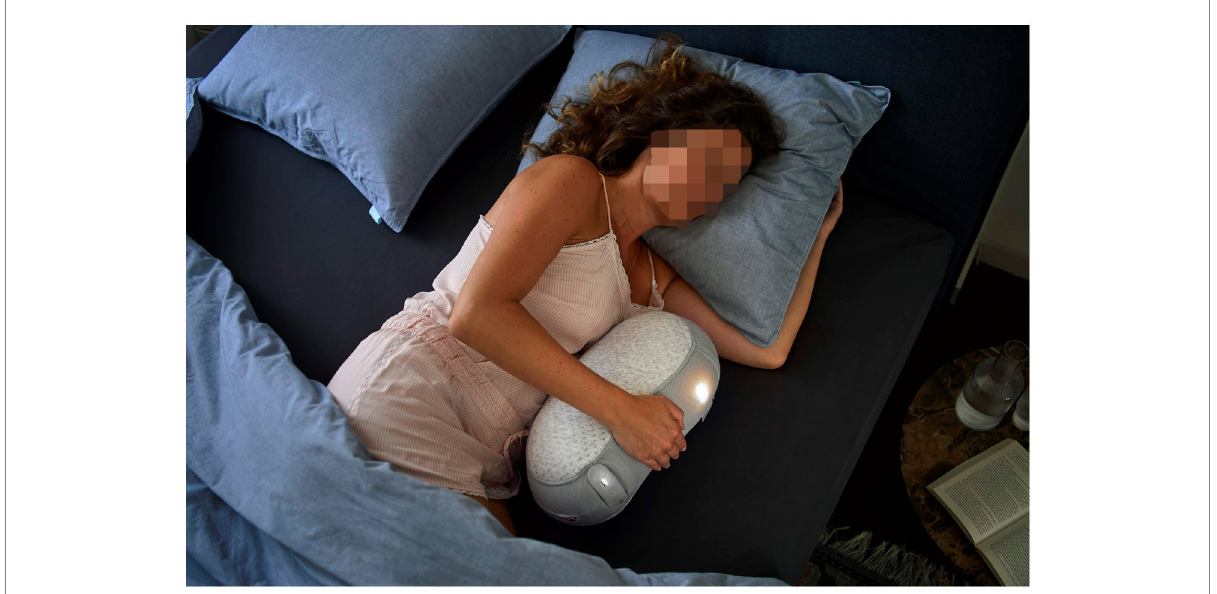
FIGURE 1 The Somnox sleep robot. Reproduced with permission from Somnox, available at